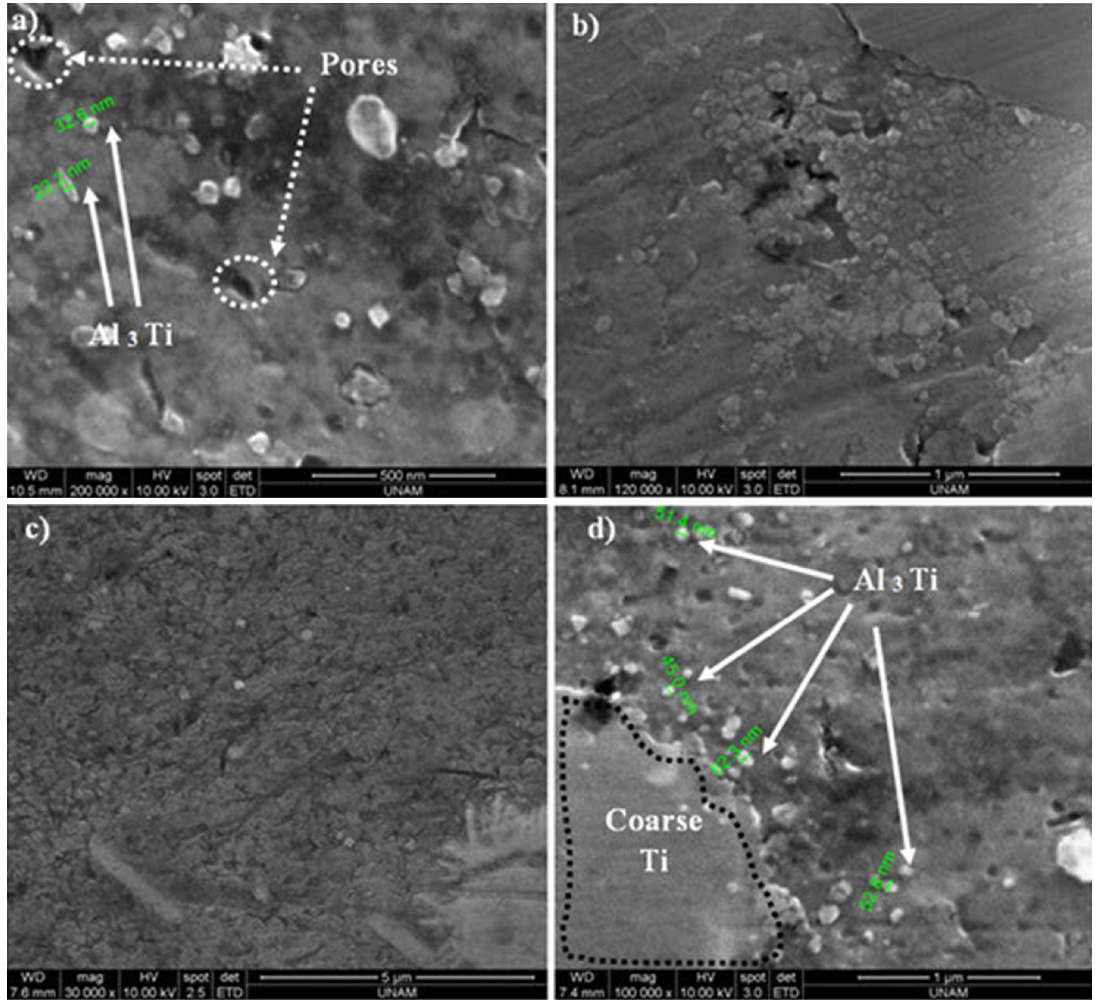
Figure 1. SEM images of A356+6% Ti AMCs synthesized at 550 °C for 1 (a), 4 (b), 8 (c) and 16 h